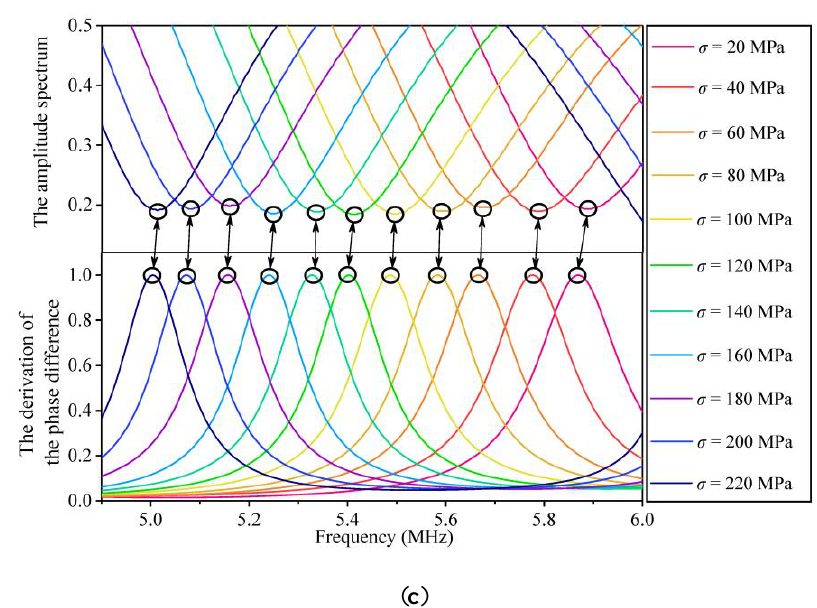
Figure 10. Comparison of the amplitude spectra and the derivation of the phase difference curves: ( a ) sample C1; ( b ) sample C2; and ( c ) sample C3.